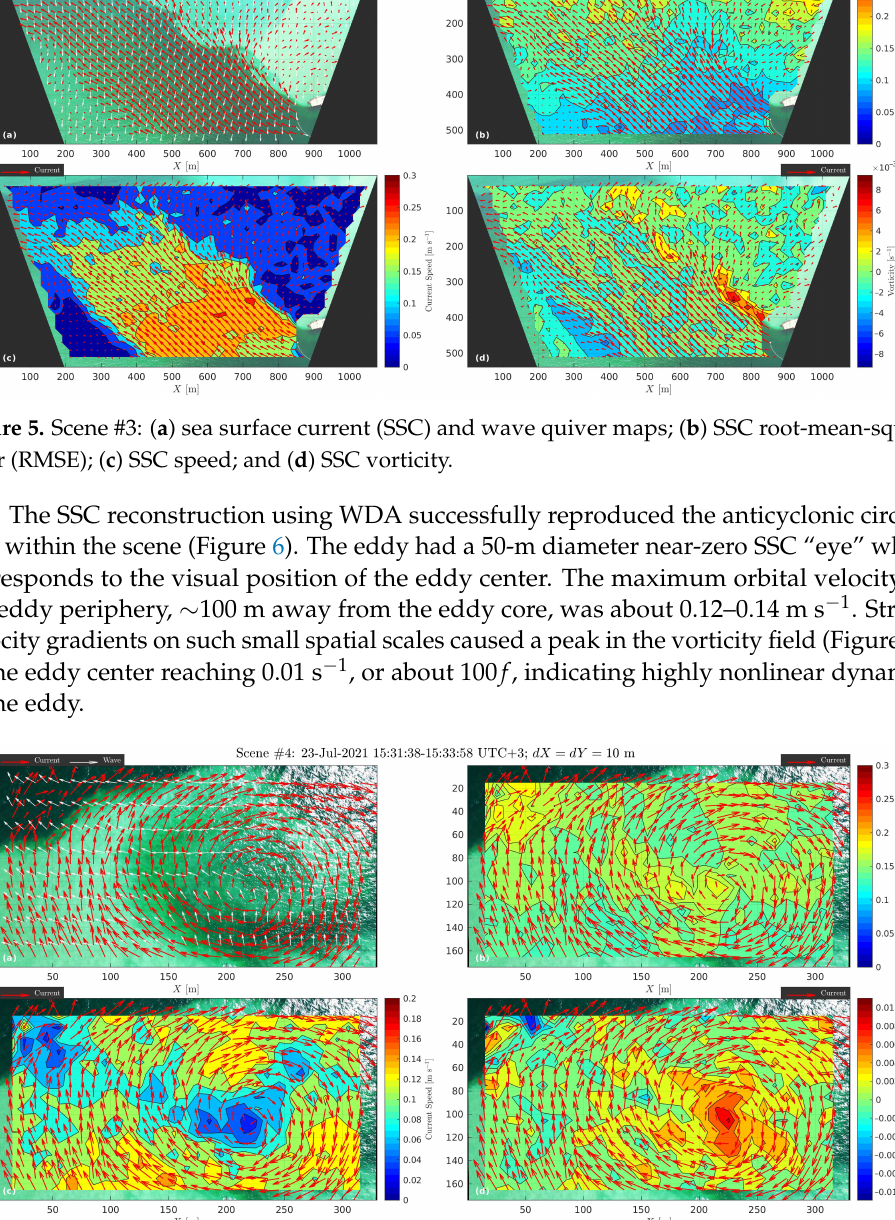
Figure 6. Scene #4: ( a ) sea surface current (SSC) and wave quiver maps; ( b ) SSC root-mean-square error (RMSE); ( c ) SSC speed; and ( d ) SSC vorticity. The wave direction field was again distorted, and this distortion is clearly correlated with the SSC maps (Figure 6a,b). The SSC RMSE was somewhat higher for the low current magnitude areas, e.g., in the eddy eye, and it was also controlled by the wave-to- current direction, as it can be deduced from the crest-like feature co-aligned with the eddy (Figure